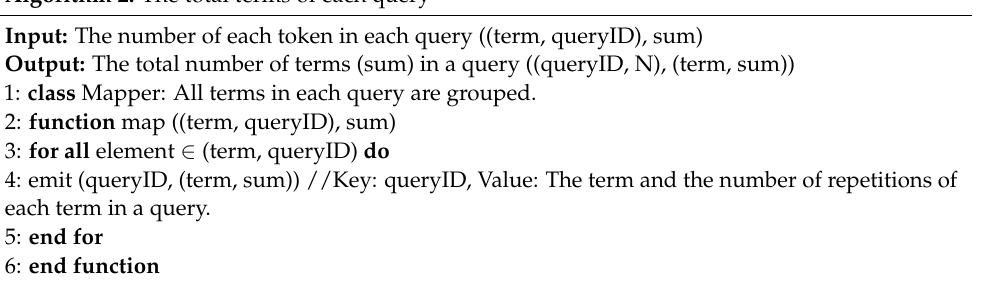
Algorithm 2: The total terms of each query